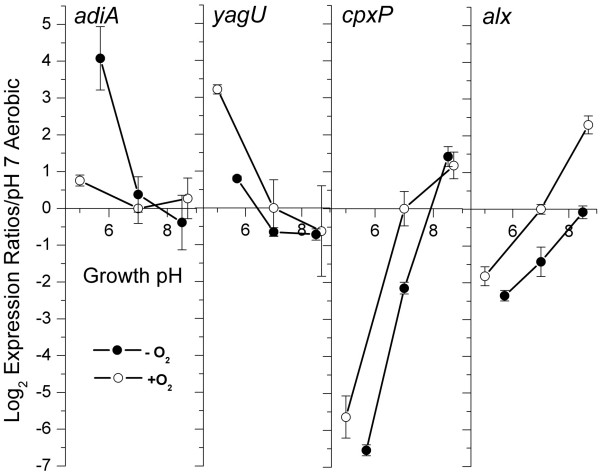
Real-time PCR expression ratios of selected genes. Bacteria were cultured in acid or base, or at pH 7.0, with aeration (○) or under oxygen limitation (●) (see Methods). For each gene, expression levels are shown for amplified message in acid or base, relative to the level at pH 7 with aeration.